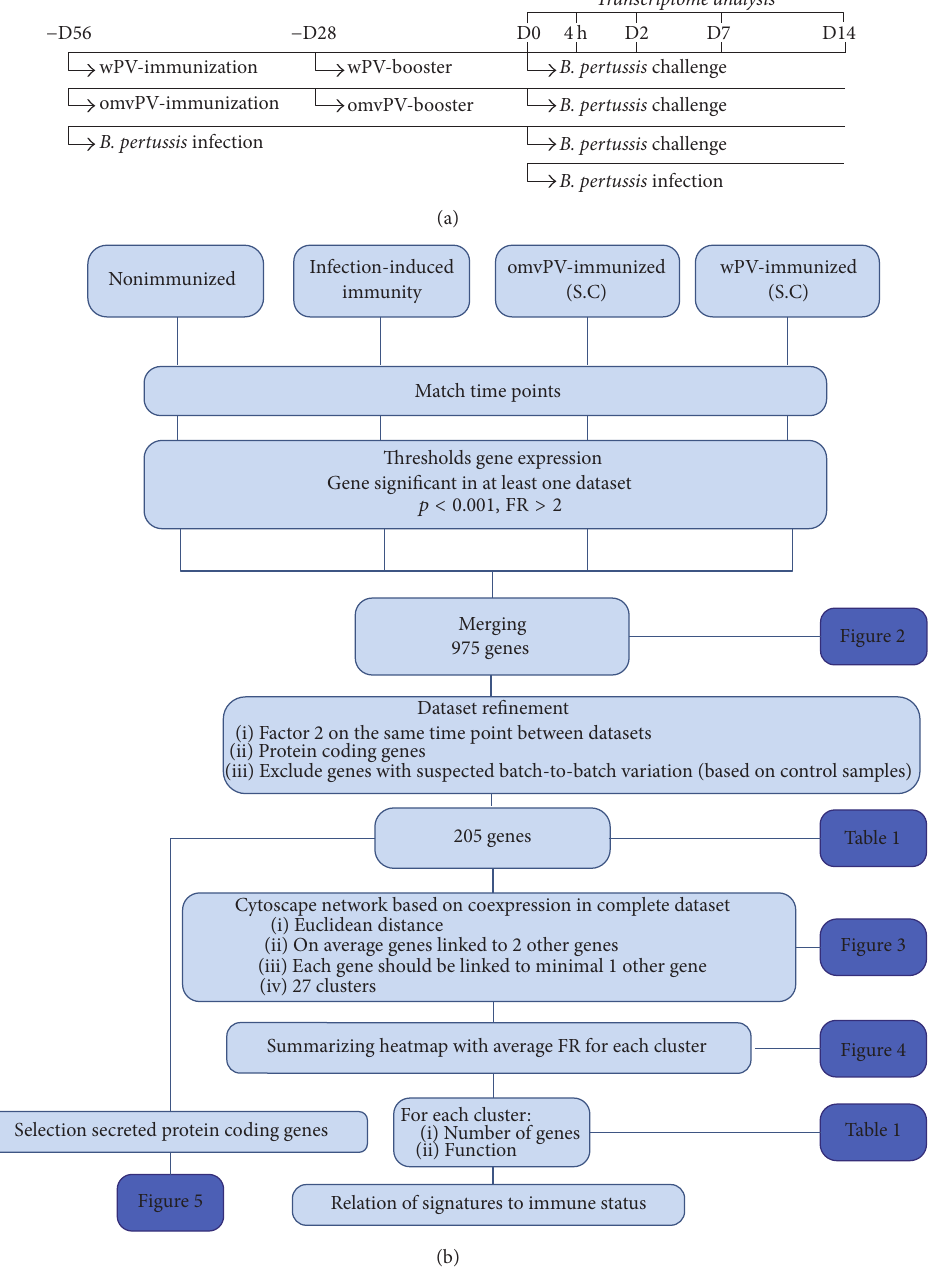
Figure 1: Design and method used in this study. Four transcriptome datasets were included obtained after a B. pertussis challenge in the lungs of nonimmunized mice, mice with infection-induced immunity, and mice immunized subcutaneously (SC) with omvPV or wPV. (a) The immunization and challenge scheme of the experiments of these datasets. (b) The different steps of the meta-analysis and criteria used are described and linked to the figures and